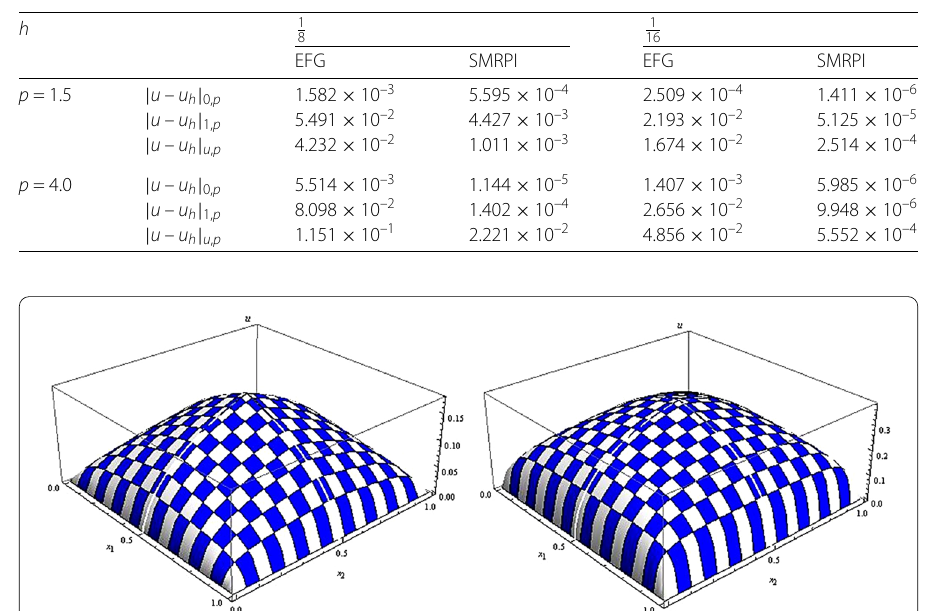
8 EFG SMRPI EFG SMRPI